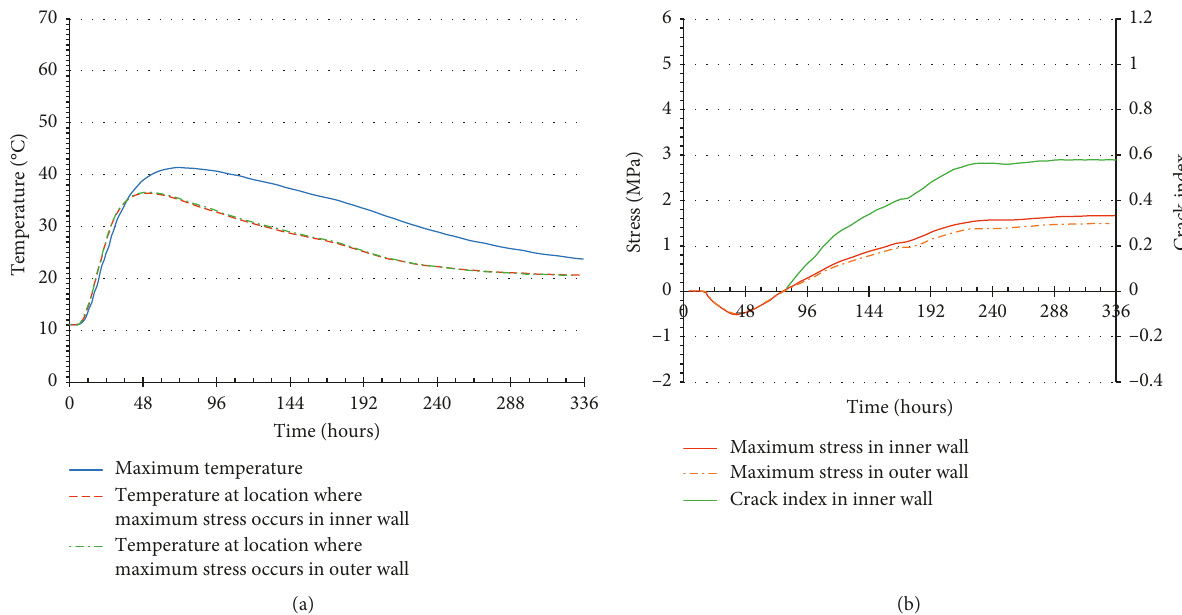
Figure 10: Calculated temperature (a) and stress (b) developments of 60% FA concrete with initial temperature 11 ° C.